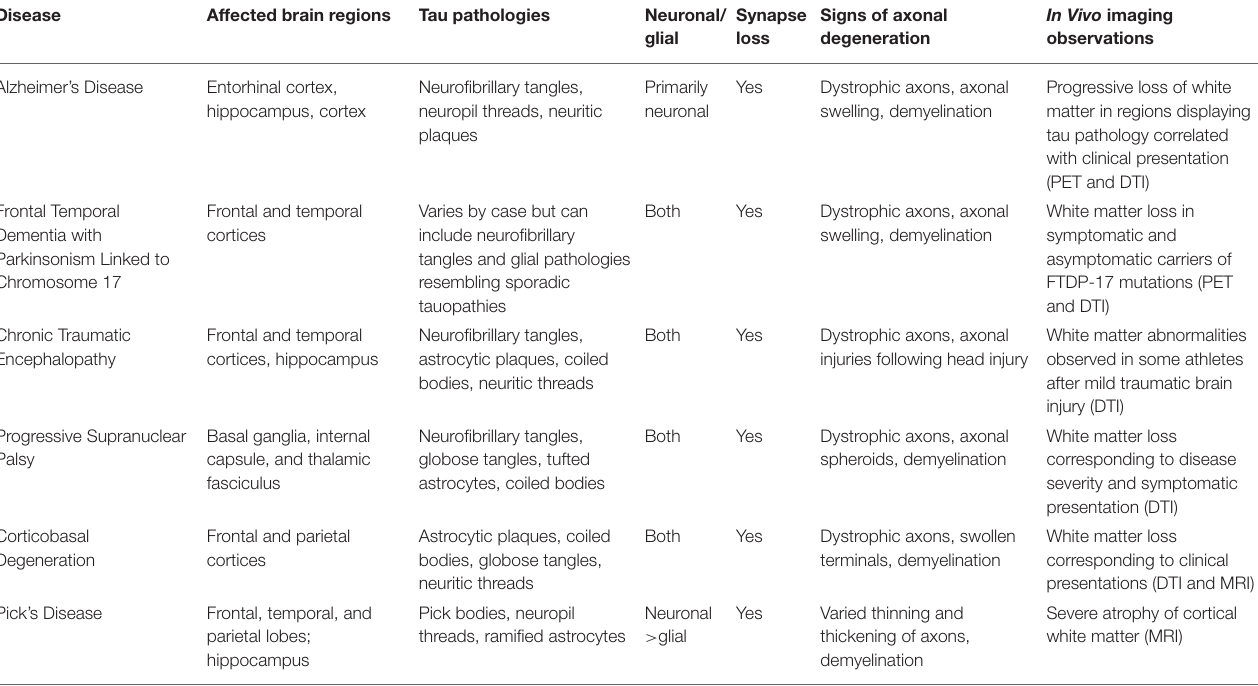
TABLE 1 | Features of axonopathy in human